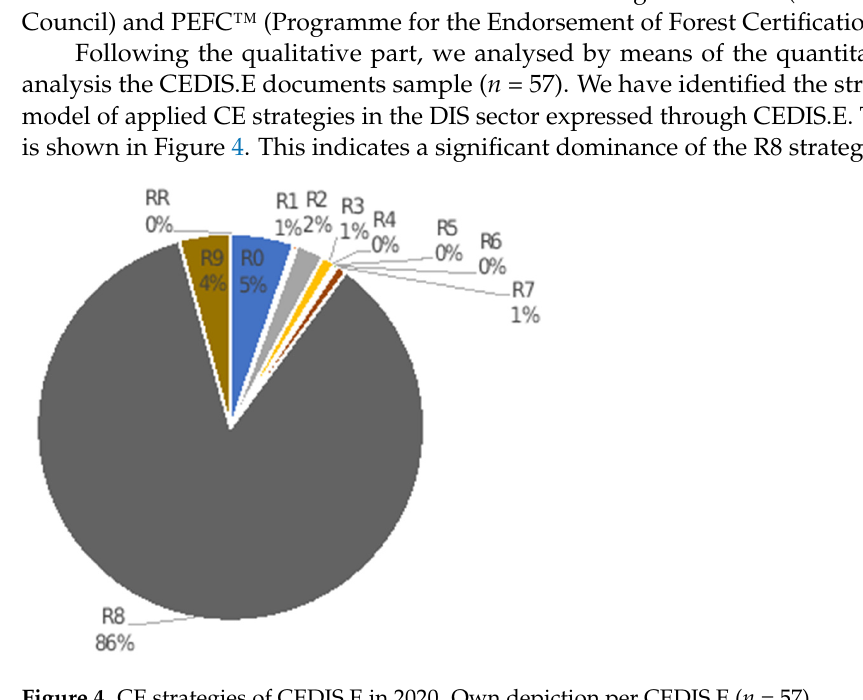
Figure 4. CE strategies of CEDIS.E in 2020. Own depiction per CEDIS.E ( n = 57).